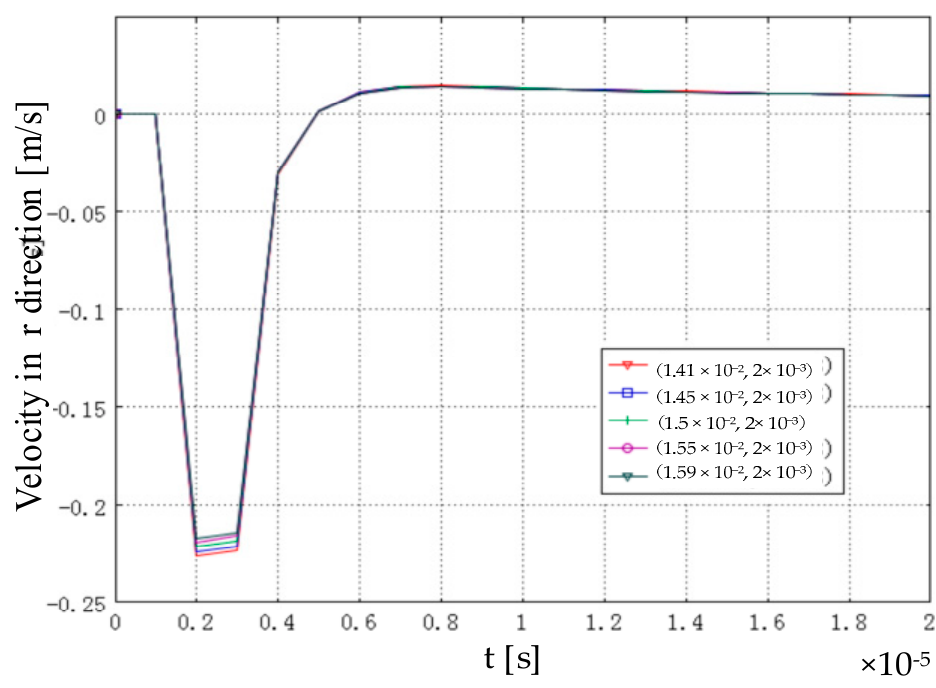
Figure 6. Velocity in r direction [m/s].